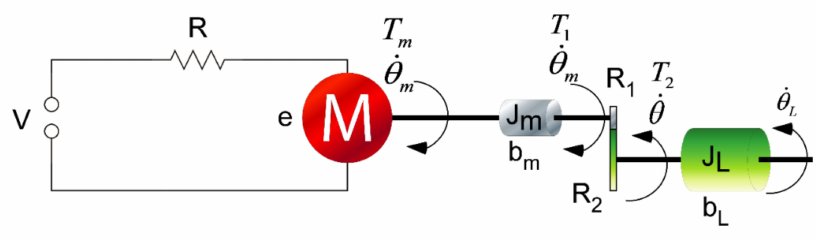
Figure A1. Model of motor–gearbox–load.